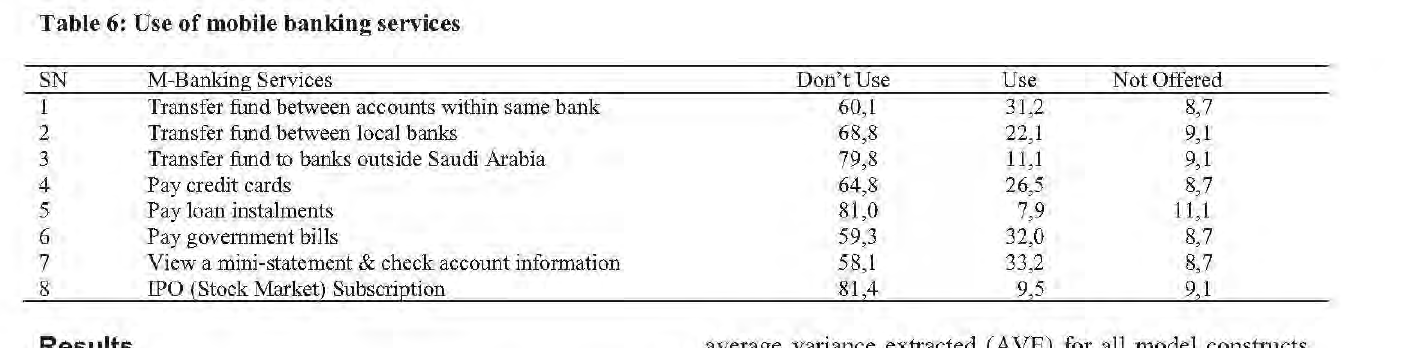
Table 6: Use of mobile banking services